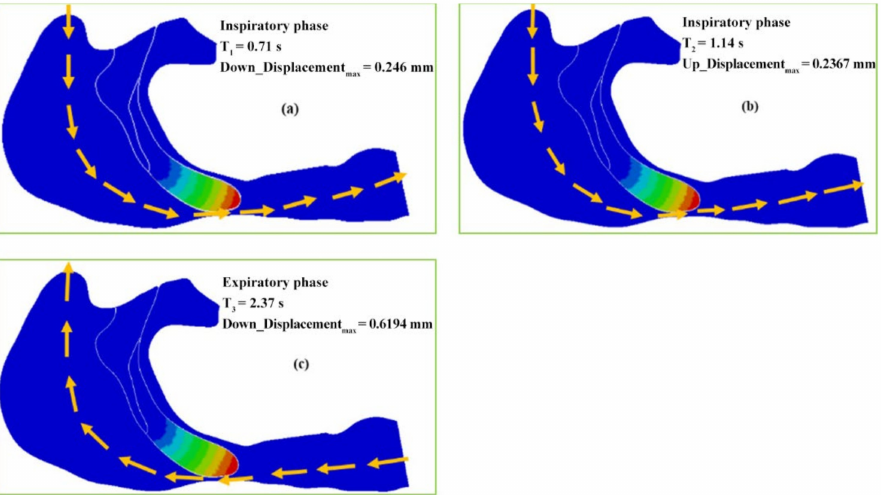
Figure 10. The maximum deformation of the OSAHS patient under eupnea: ( a ) the soft palate moves to the posterior wall of the pharynx during the inspiration phase, ( b ) the airway is more open during the inspiration phase, and ( c ) the airflow pass through the pharyngeal cavity during the expiration